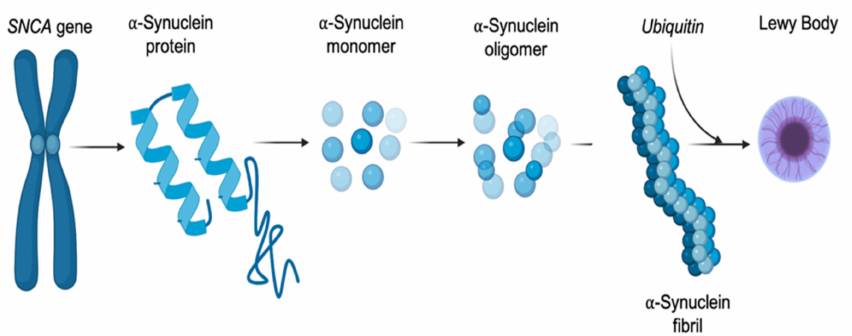
Figure 2. The pathway of alpha-synuclein ( α Syn) dysregulation. Modification and mutations within the SNCA gene can alter the expression of the encoded α Syn protein, facilitating the protein down a fibrillar pathway, leading to misfolding and